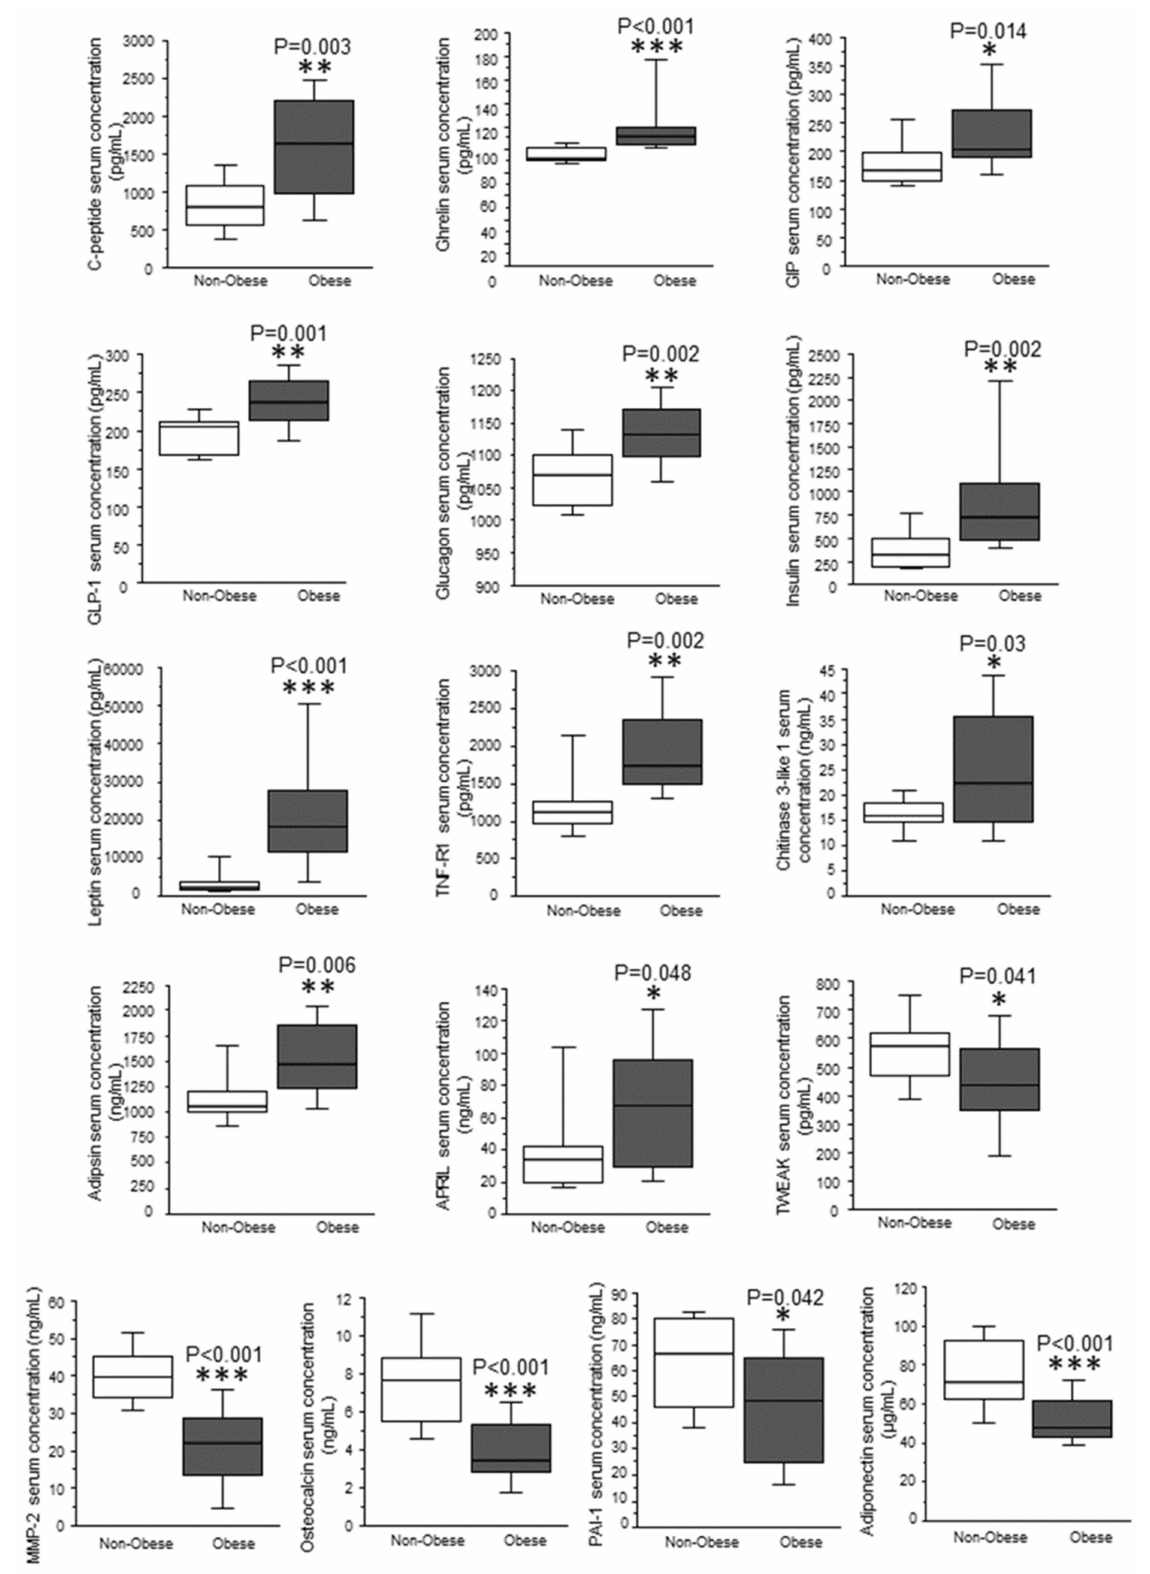
Figure 2. Changes in protein serum levels due to obesity. Box-plot diagram showing the effect of obesity on the serum proteomic profile. Data represented as mean ± SEM, statistical analysis was performed by Mann–Whitney U tests. * p < 0.05; * * p < 0.01; ** * p <